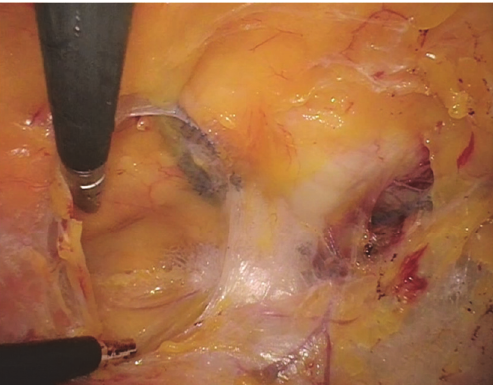
Figure 2: Identification of the arms of the RP sling entering through the pubocervical fascia and extending up to the abdominal wall within the retropubic space. Permission to reprint from Miklos and Moore.